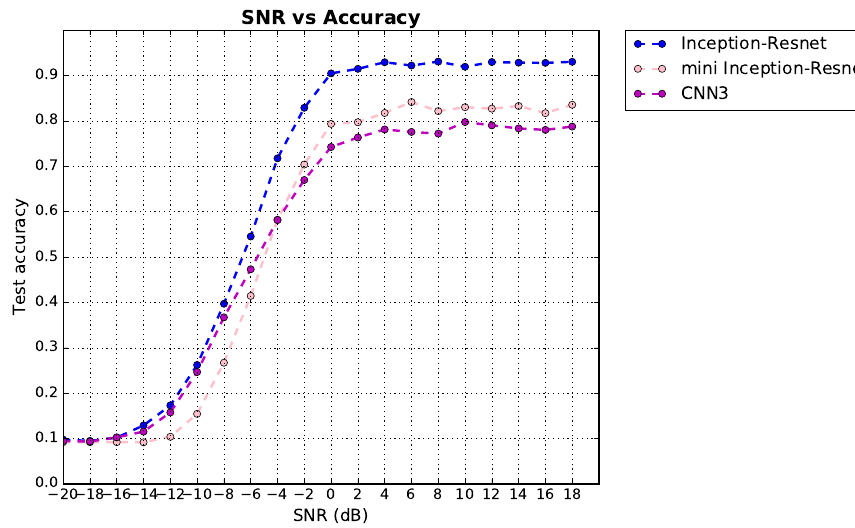
Figure 11. The classification accuracy of teacher and student